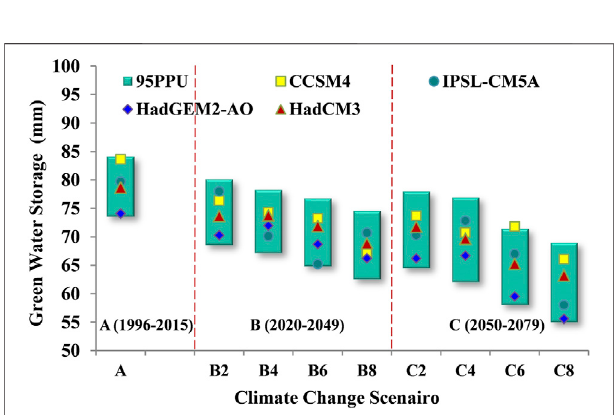
FIGURE 7 | Annual average green water storage in different climate scenarios in the Xiangjiang River Basin.